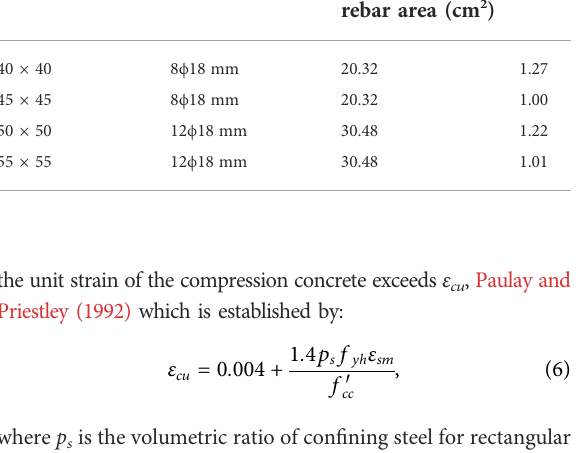
ρ rebar area (cm 2 )